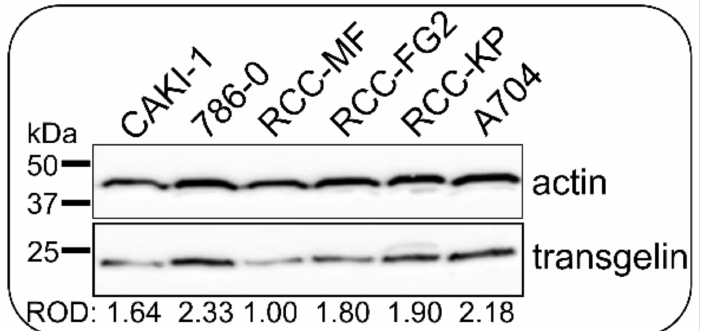
Figure 3. Level of transgelin protein in the panel of ccRCC cell lines. The transgelin level was tested in 20 µ g of total protein lysate using immunoblotting. The transgelin/actin ROD ratio was normalized to the RCC-MF cell sample. The highest ROD was detected in 786-0 cells, which were then used in the functional characterization of